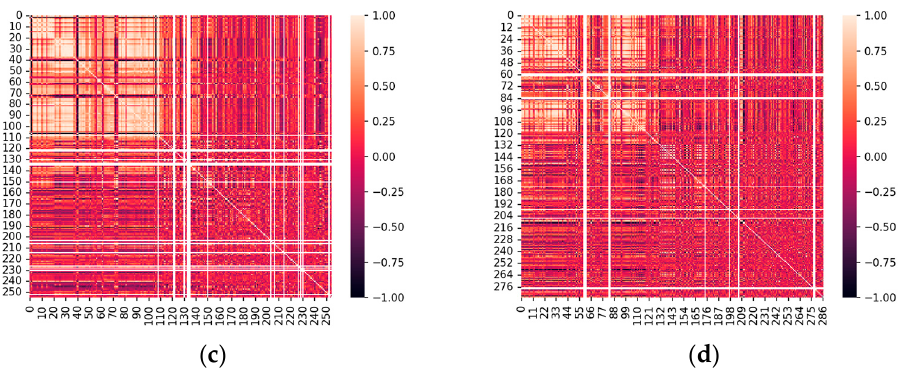
Figure 6. Correlation of features selected for the four datasets. ( a ) Feature correlation representation of spring dataset; ( b ) feature correlation representation of summer dataset; ( c ) feature correlation representation of autumn dataset; ( d ) feature correlation representation of winter dataset.